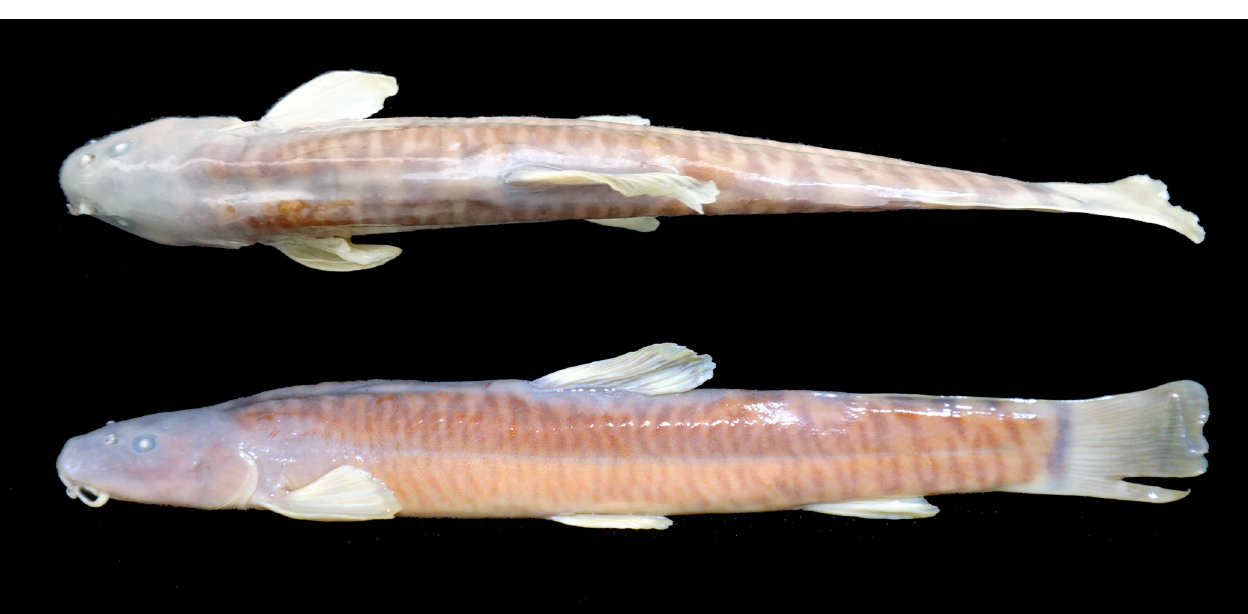
Fig 7. Left lateral and dorsal views of Homatula microcephala , holotype SWFU 0612057, 90.2 mm SL; China: Yunnan Prov.: Dali Pref.: Yunlong Co.: Jiancao